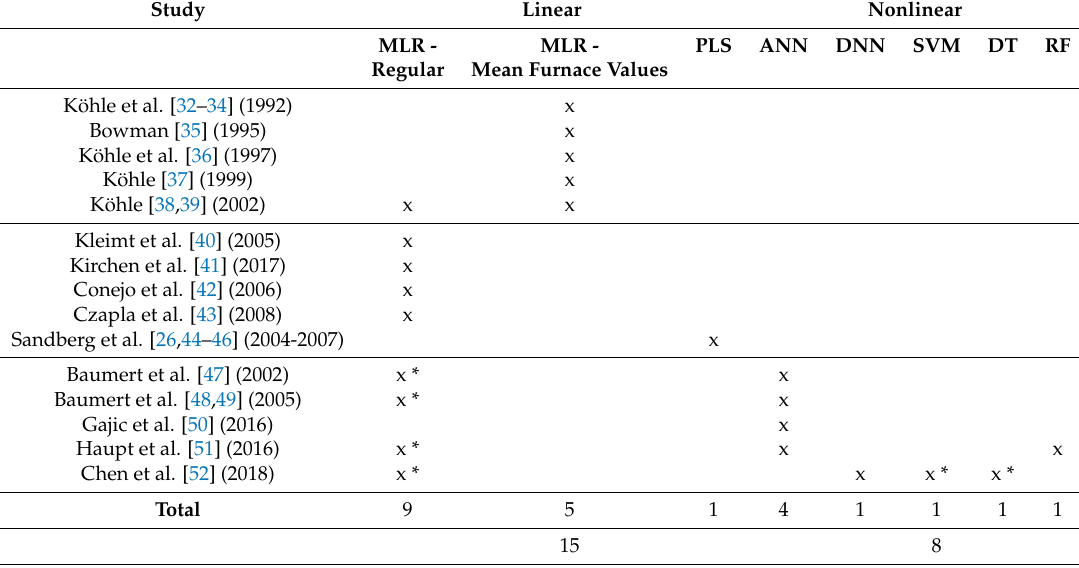
Table 3. Studies where new statistical models were created or where new data were applied on previously reported models. Each study can contain references to multiple articles if the results or details about the model(s) are spread over multiple sources. Some studies have used both linear and nonlinear models. Abbreviations: Multivariate Linear Regression (MLR); Partial Least Squares (PLS); Artificial Neural Network (ANN); Deep Neural Network (DNN); Support Vector Machine (SVM); Decision Tree (DT); Random Forest (RF). * Used as comparative models and is not the main model